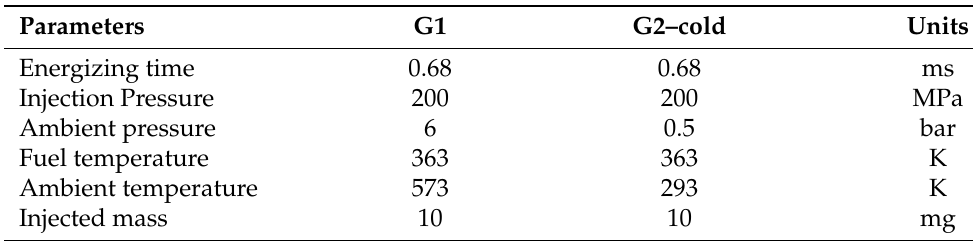
Table 4. Operating